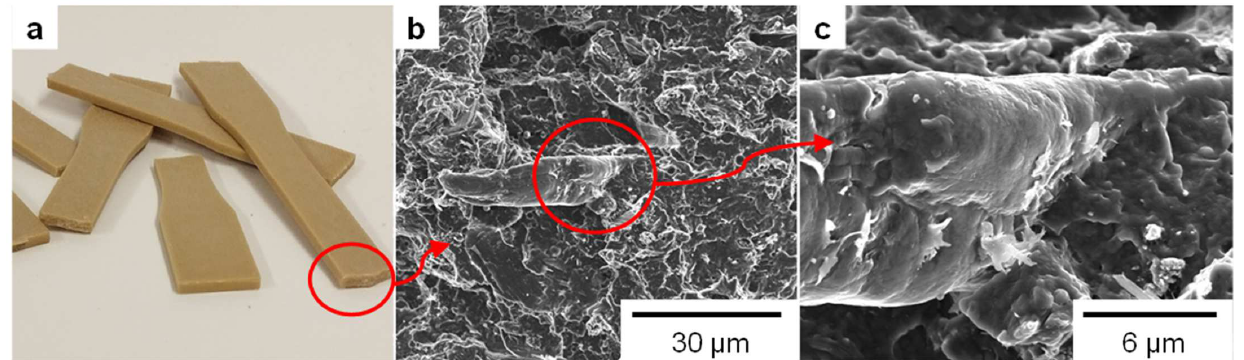
Figure 4. Pictures ( a ) and cross-sectional micrographs at two levels of magnification, 1000× ( b ) and 5000× ( c ), showing the fracture section of dog-bone specimens of PLA/SBHF biocomposites.